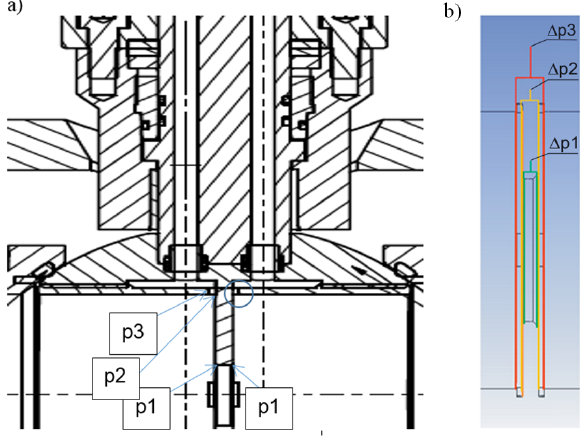
Figure 11: Pressure measurement points and differential pressure, p1 ( ∆ p1) - measurement on the edge of the orifice hole, p2 ( ∆ p2) - measurement on the edge of the hole closer to the front face of the orifice, p3 ( ∆ p3) - measurement on the edge of the orifice hole located further on the orifice plane, a) view of pressure measure- ment points in the valve cross-section, b) view of the measurement locations on the sketch of the calculation program Table 1: Calculated air pressure difference for single-hole and